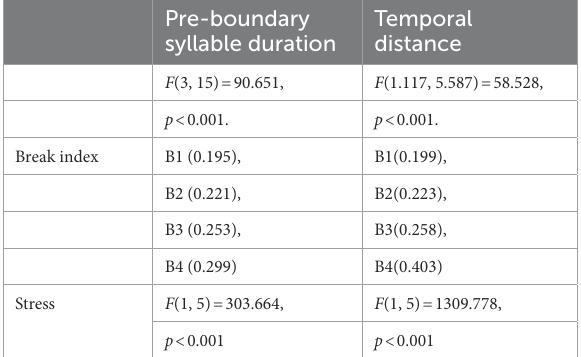
TABLE 4 Results of repeated measures ANOVAs on the effect of break index and stress on pre-boundary syllable duration and temporal distance in